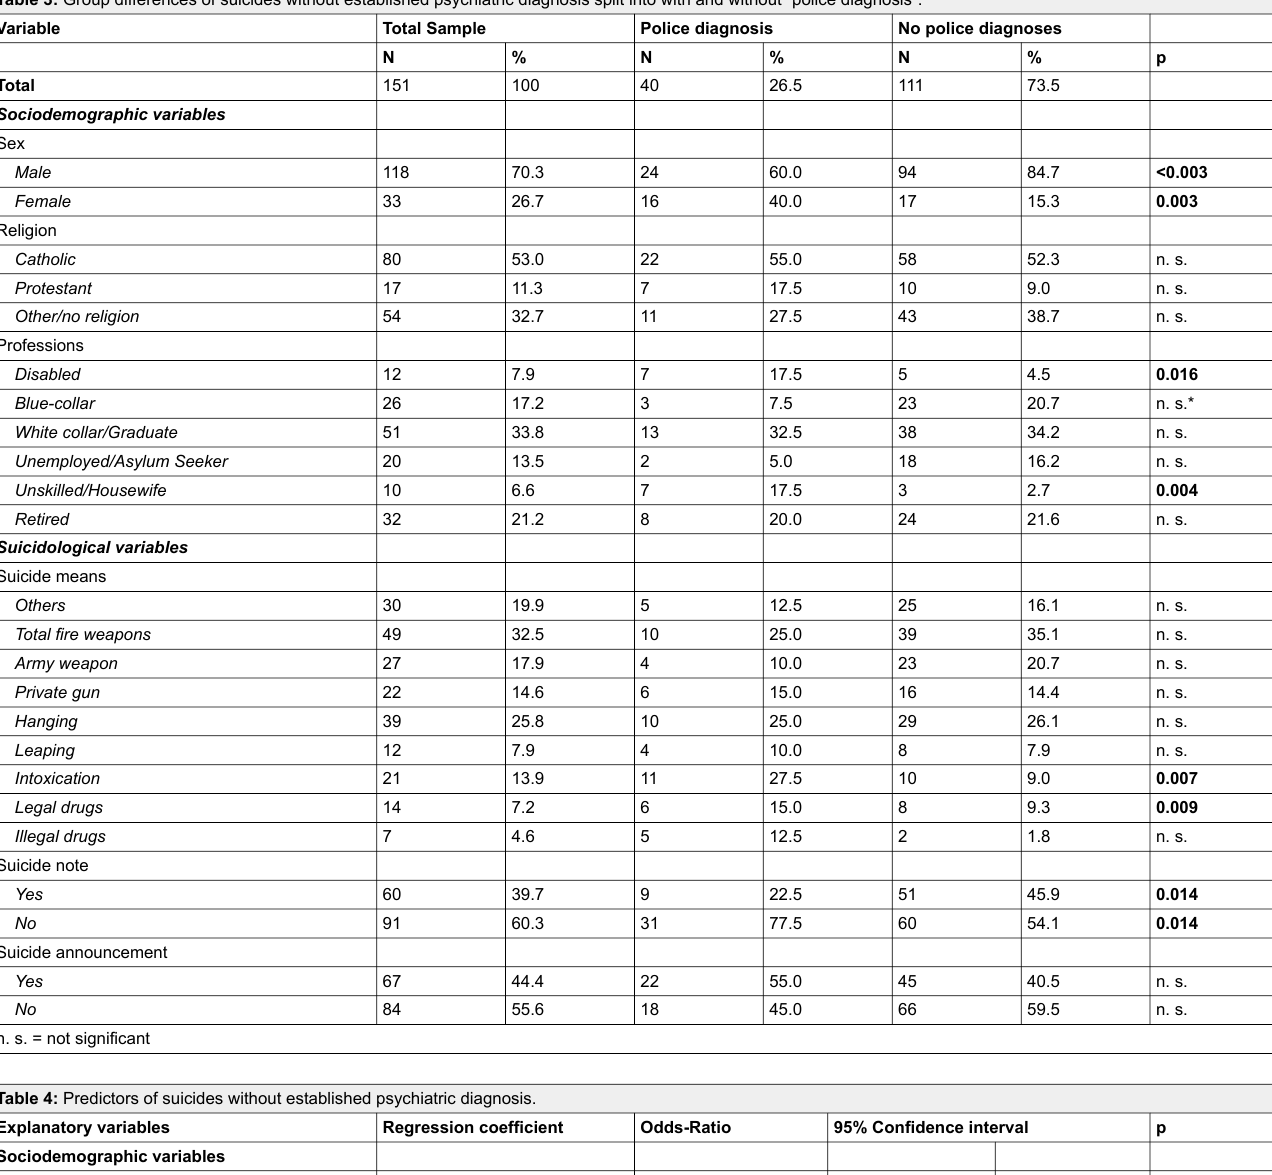
Table 3: Group differences of suicides without established psychiatric diagnosis split into with and without “police diagnosis”. Variable